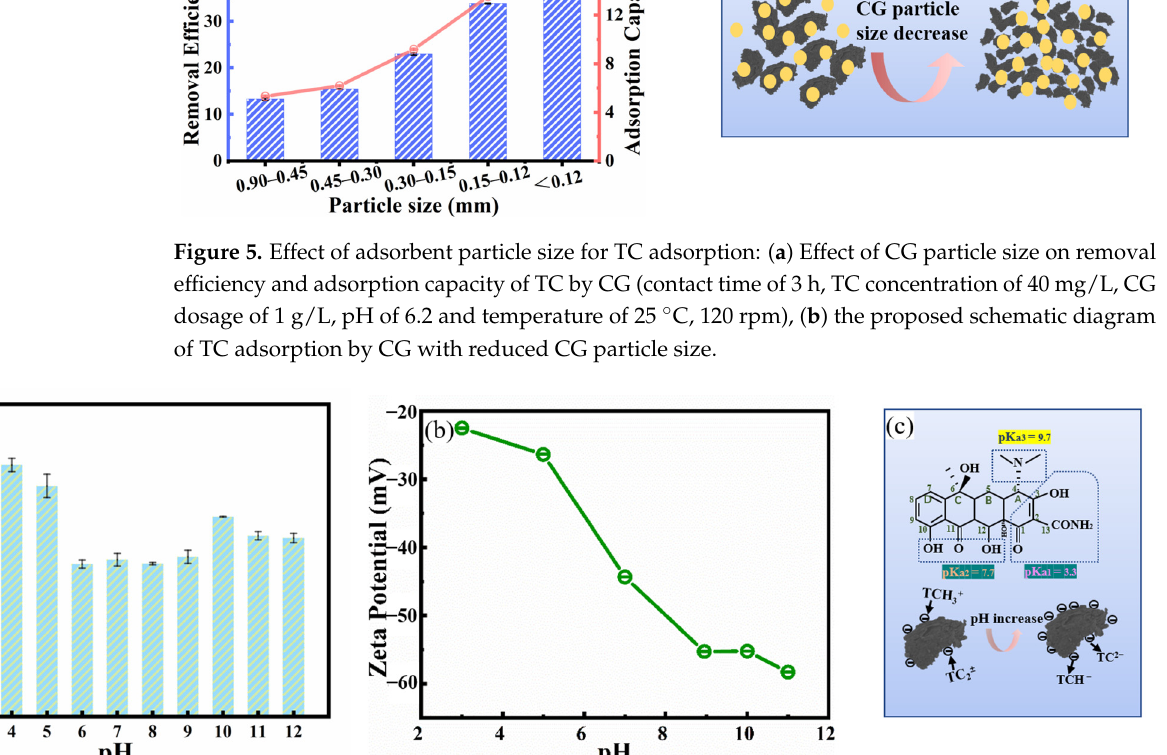
Figure 6. Effect of solution pH for TC adsorption: ( a ) Effect of solution pH on removal efficiency of TC by CG (contact time of 3 h, TC concentration of 40 mg/L, CG dosage of 1 g/L, contact temperature of 25 °C, and stirring speed of 120 rpm); ( b ) the Zeta potential of CG with increasing pH in an aqueous solution, ( c ) the proposed schematic diagram of TC adsorption by CG with increasing solution pHs.